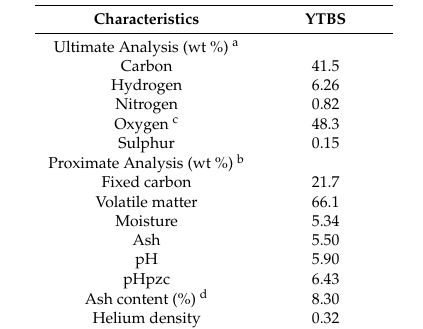
Table 1. Physical and chemical characteristics of white yam tuber peel (YTBS) adsorbent.